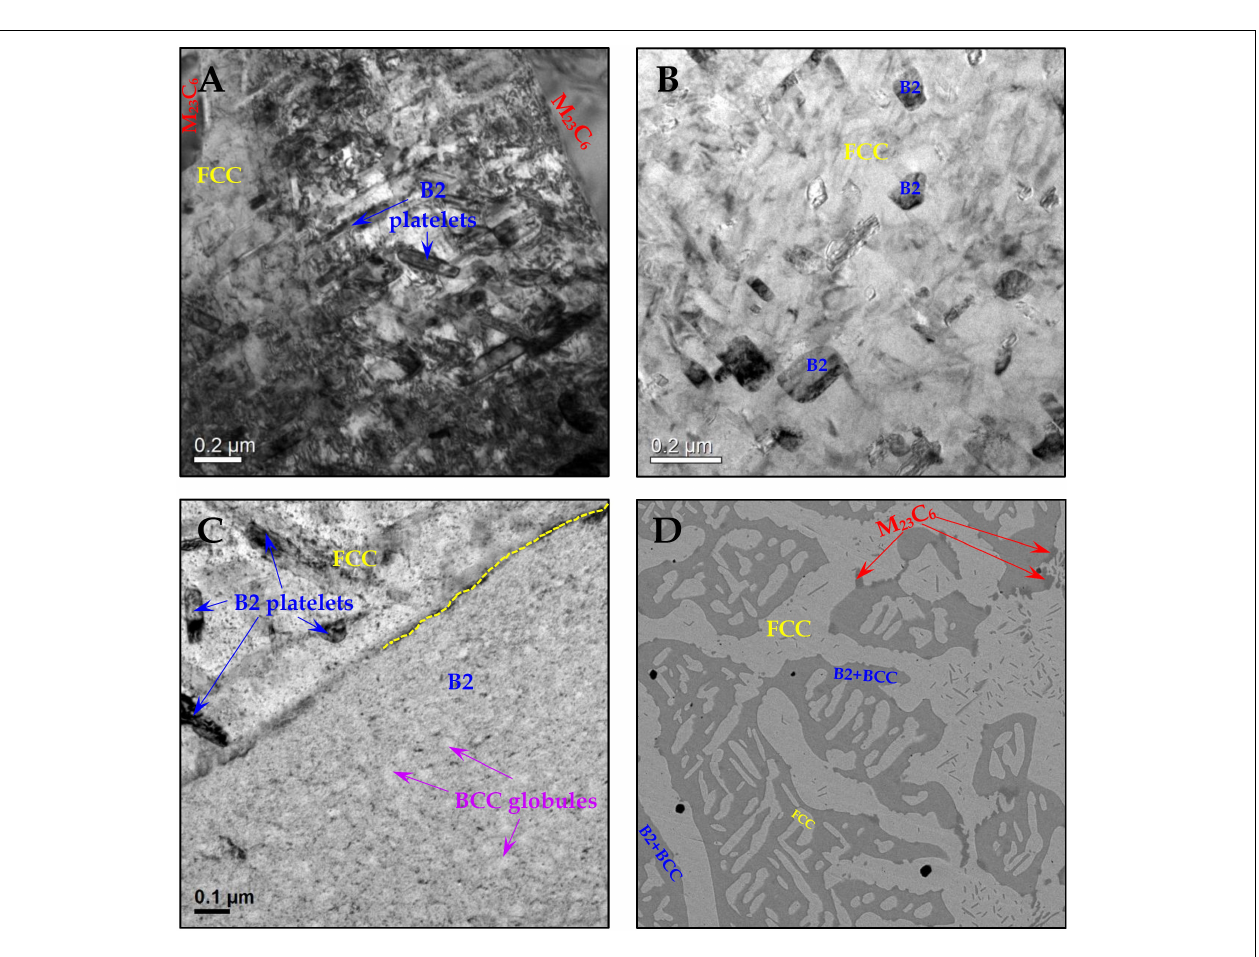
Frontiers in Materials |